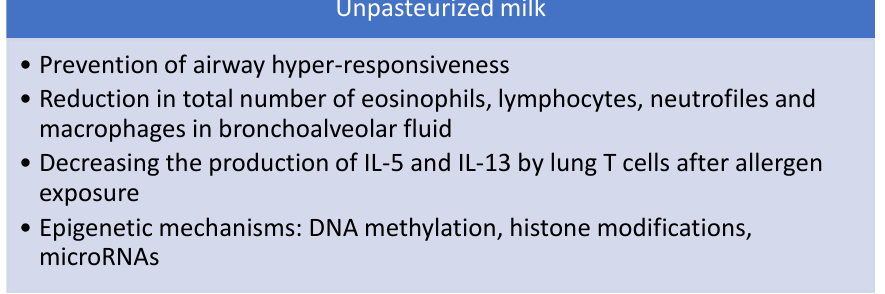
Figure 3. Proposed mechanism of action of unpasteurized milk in asthma primary prevention. Some immunomodulatory cytokines present in bovine milk such as TGF-β and IL-10